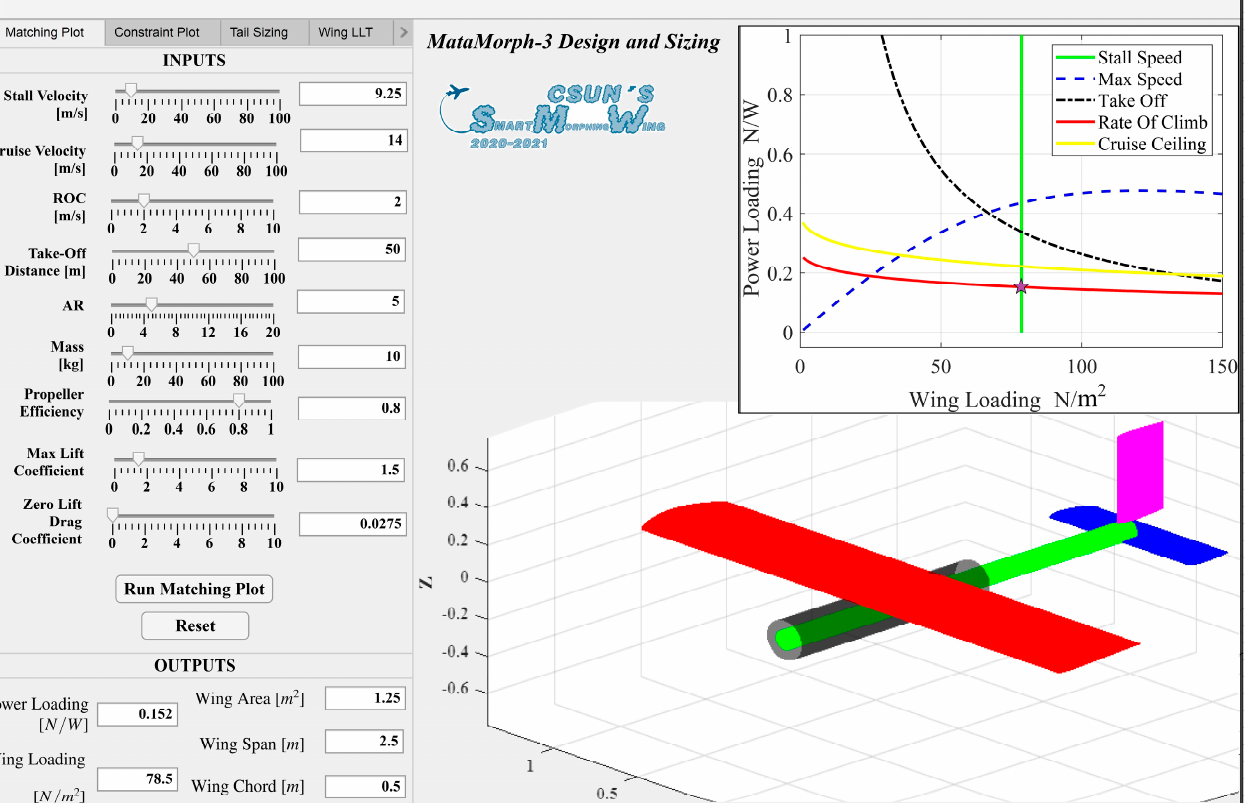
Figure 1. MataMorph-3 Design and Sizing